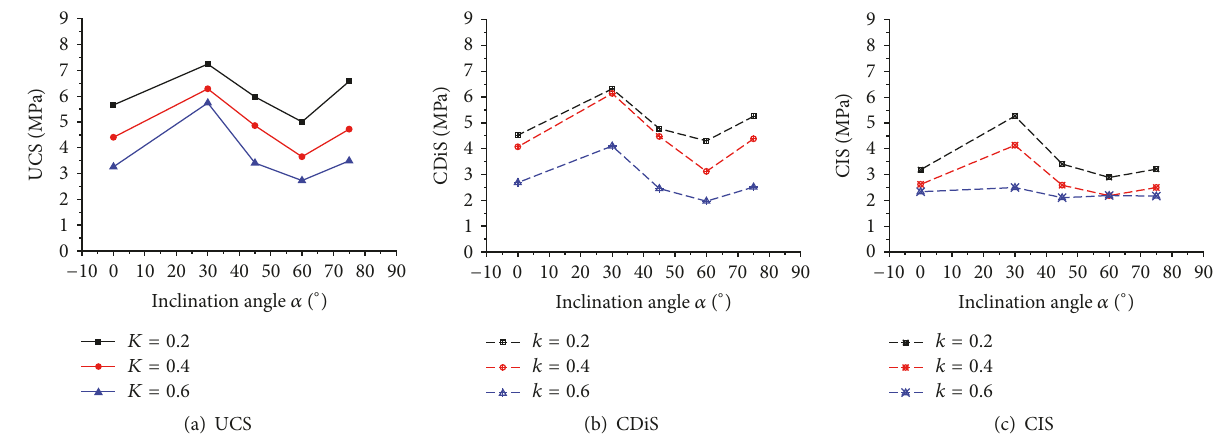
Figure 10: Effect of joint persistency ( 𝑘 ) on the characteristic stresses: (a) UCS; (b) CDiS; and (c) CIS.